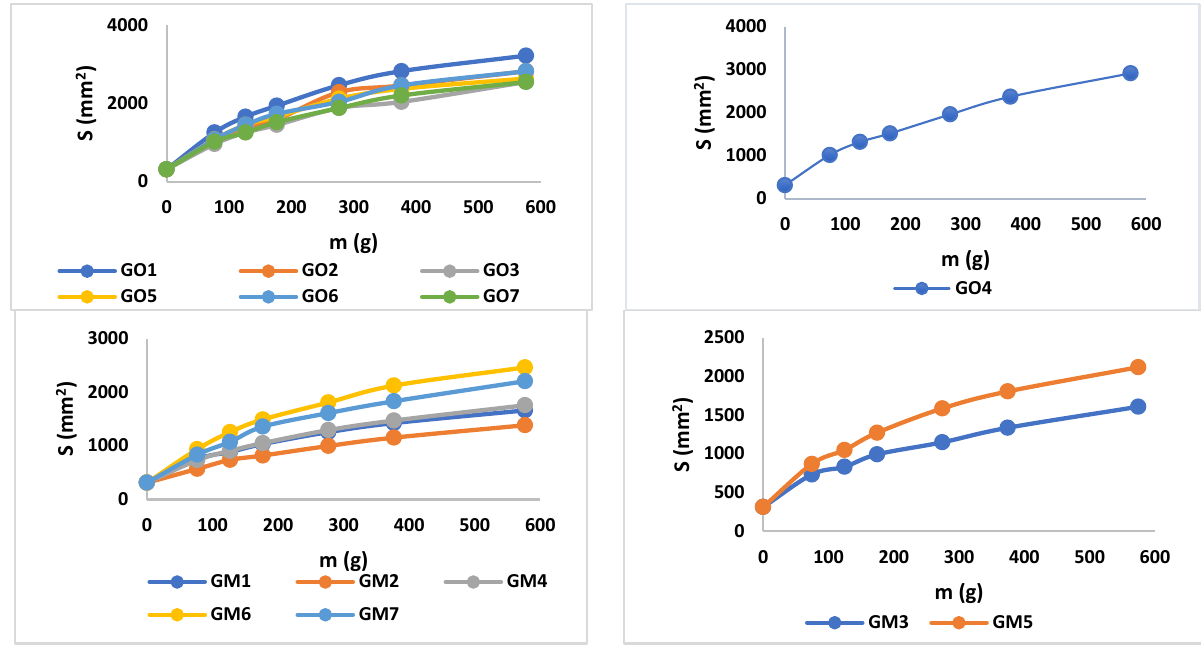
Figure 5. Spreadability profiles for blank and MIC gels.